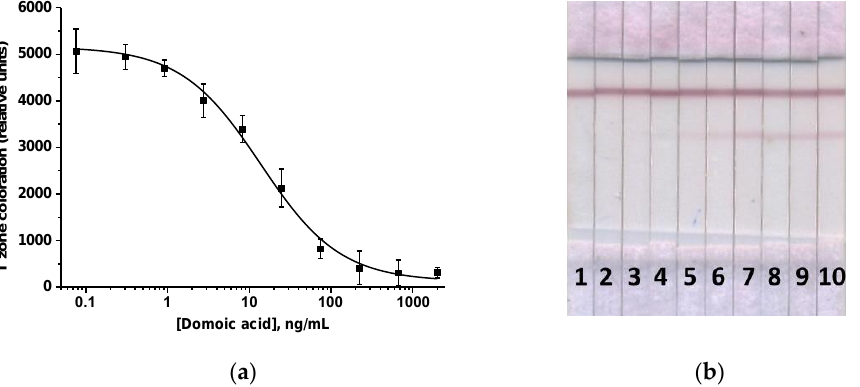
Figure 3. ICA of DA. ( a ) Calibration curve (n = 3). ( b ) The appearance of test strips after the assay. Samples 1 – 10 accord to 2000, 667, 222, 74, 21, 8.2, 2.7, 0.9, 0.3, and 0.08 ng/mL of DA.